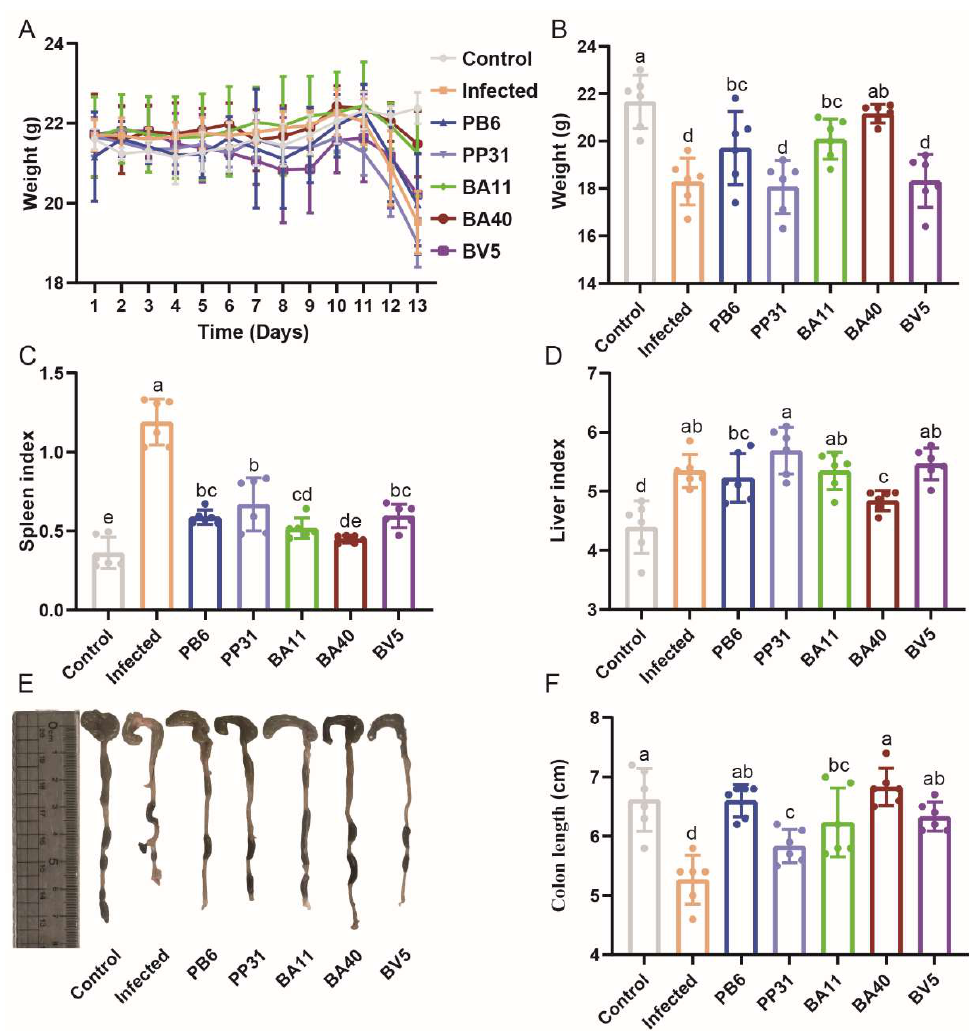
Figure 6. The protective effect of probiotic candidates against Clostridium perfringens infection in mice. ( A ) Bodyweight (BW). ( B ) At the end of experiment, mice weight. ( C ) The spleen index. ( D ) The liver index. ( E ) The colon images ( F ) The colon length. a, b, c, d Means values with dissimilar letters